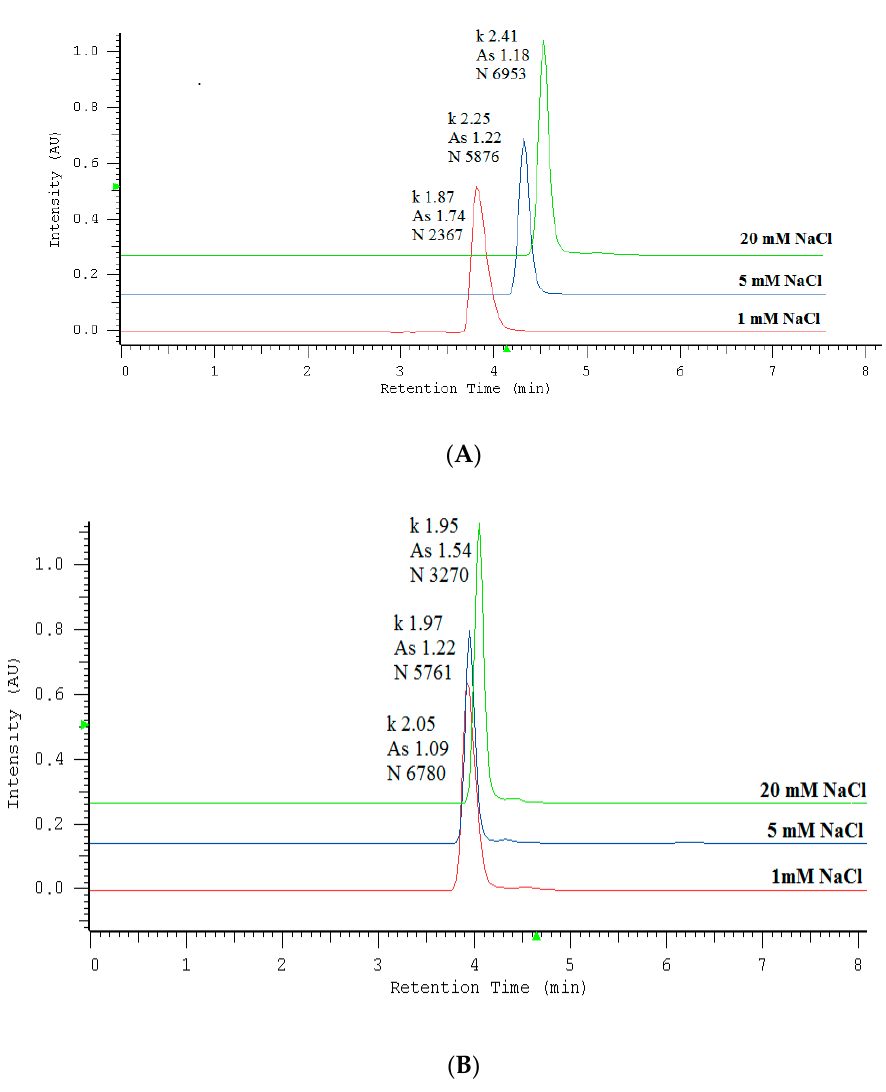
Figure 1. Chromatograms illustrating influence of NaCl in the mobile phase on the parameters of NO 3 − ( A ) and NO 2 − ( B ) peaks. The column was IAM.PC.DD2 Regis HPLC Agilent Technologies, the flow rate of the mobile phase was 0.5 mL/min, the injected volume 3 µL, and the analytical wavelength of 210 nm. The abbreviation k stands for retention factor, A s denotes the symmetry factor and N is the theoretical plate number.